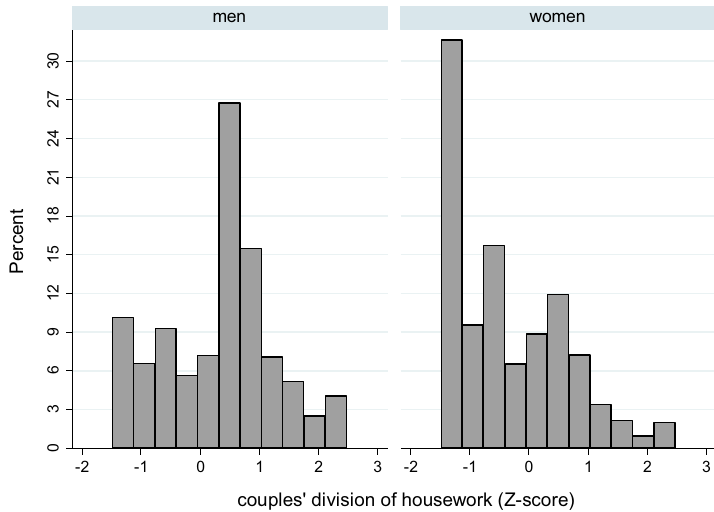
Fig. 2 Symmetry in the division of instrumental household tasks according to respondent’s gender (5 items). Higher values, more